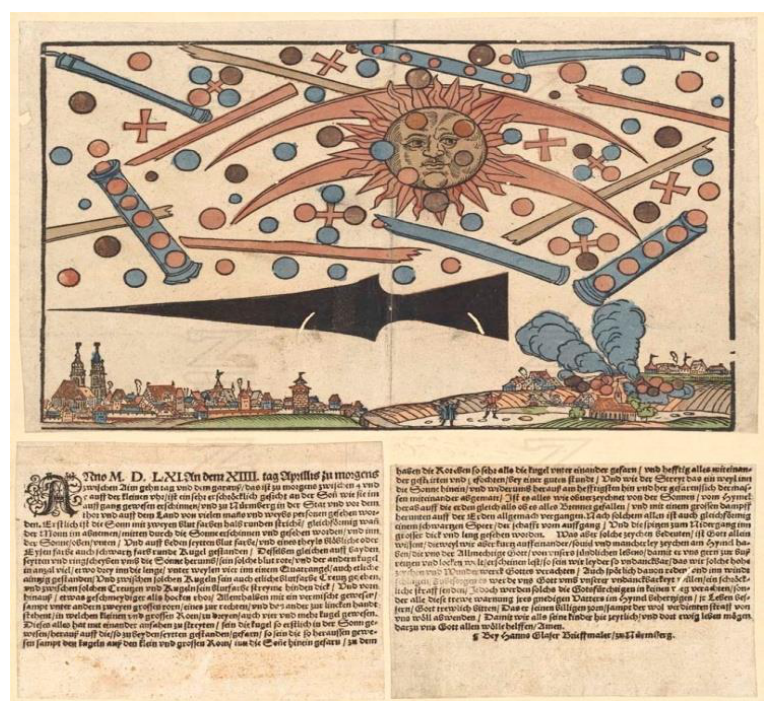
Figure 14. Shapes sighted over Nuremberg, 1561.